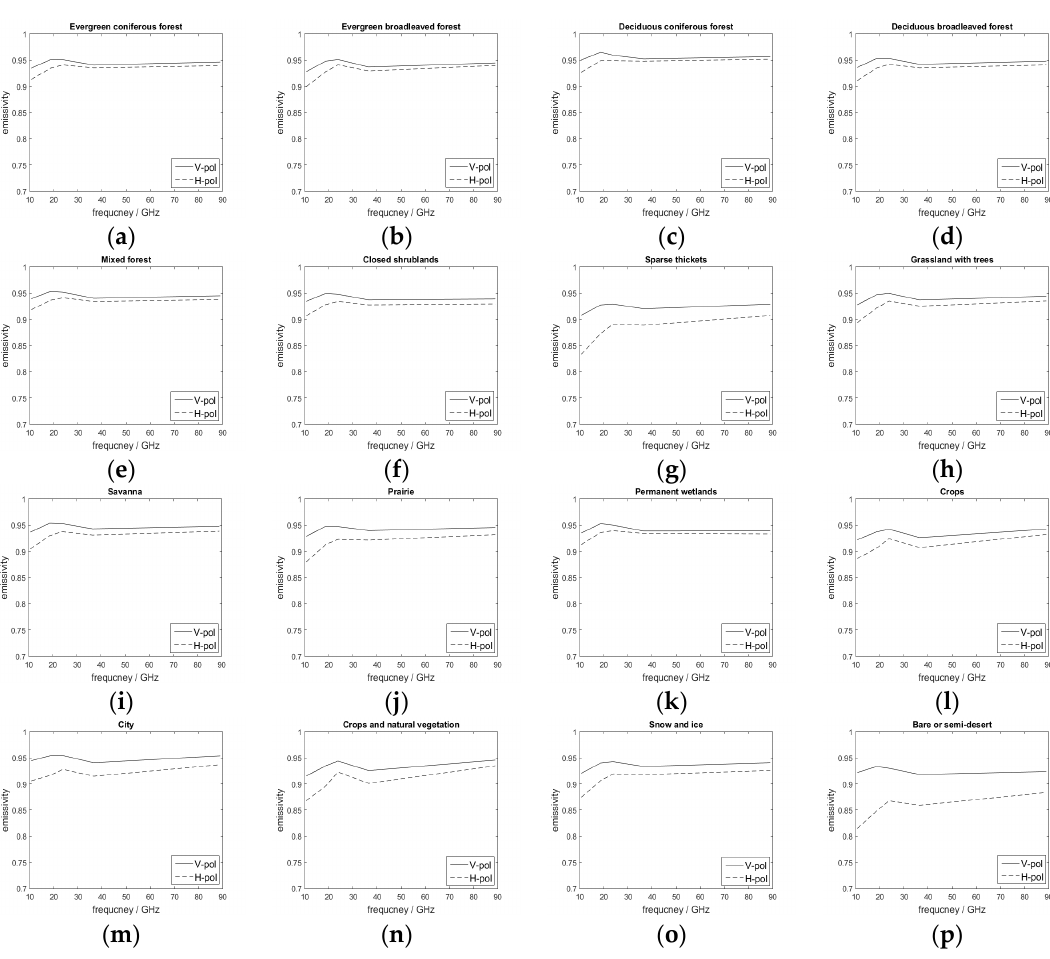
Figure 5. Land surface emissivity spectra: ( a ) evergreen coniferous forest; ( b ) evergreen broadleaved forest; ( c ) deciduous coniferous forest; ( d ) deciduous broadleaved forest; ( e ) mixed forest; ( f ) closed shrublands; ( g ) sparse thickets; ( h ) grassland with trees; ( i ) savanna; ( j ) prairie; ( k ) permanent wetlands; ( l ) crops; ( m ) city; ( n ) crops and natural vegetation; ( o ) snow and ice; and ( p ) bare or semi-desert.